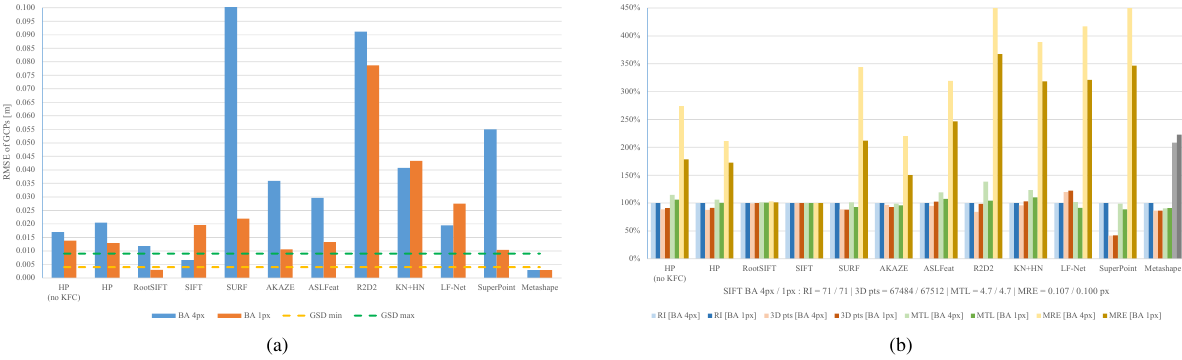
Figure 10. Paestum Wall Normal dataset: (a) RMSEs of the CPs and (b) BA statistics as percentages with respect to SIFT values (OPENCV camera model with PP post-refinement, mTL=3). The min e max GSDs are reported with respect to the downsampled images.